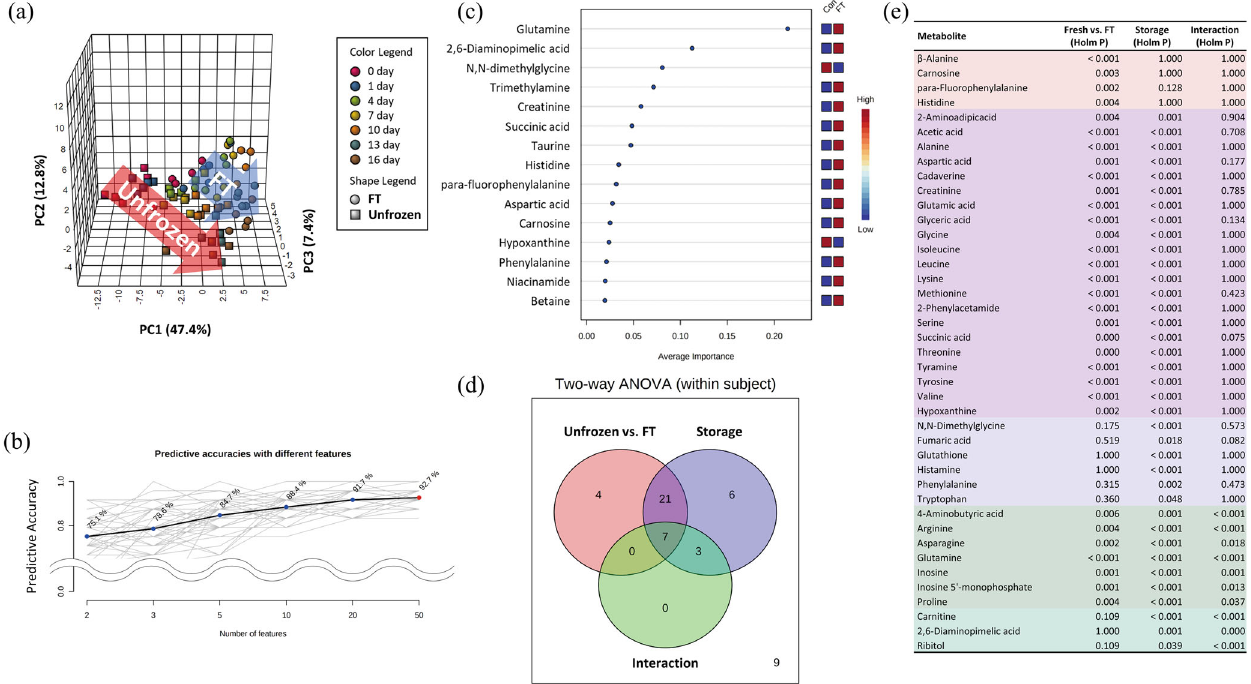
Fig. 1 Trends in whole metabolic changes of unfrozen and frozen/thawed chicken meat by storage time. Interactive principal component analysis (iPCA) ( a ), predictive accuracies with different features ( b ), average importance with 50 features prediction model ( c ), Venn diagram of two-way ANOVA ( d ), and list of metabolites which have signi fi cance ( e ).